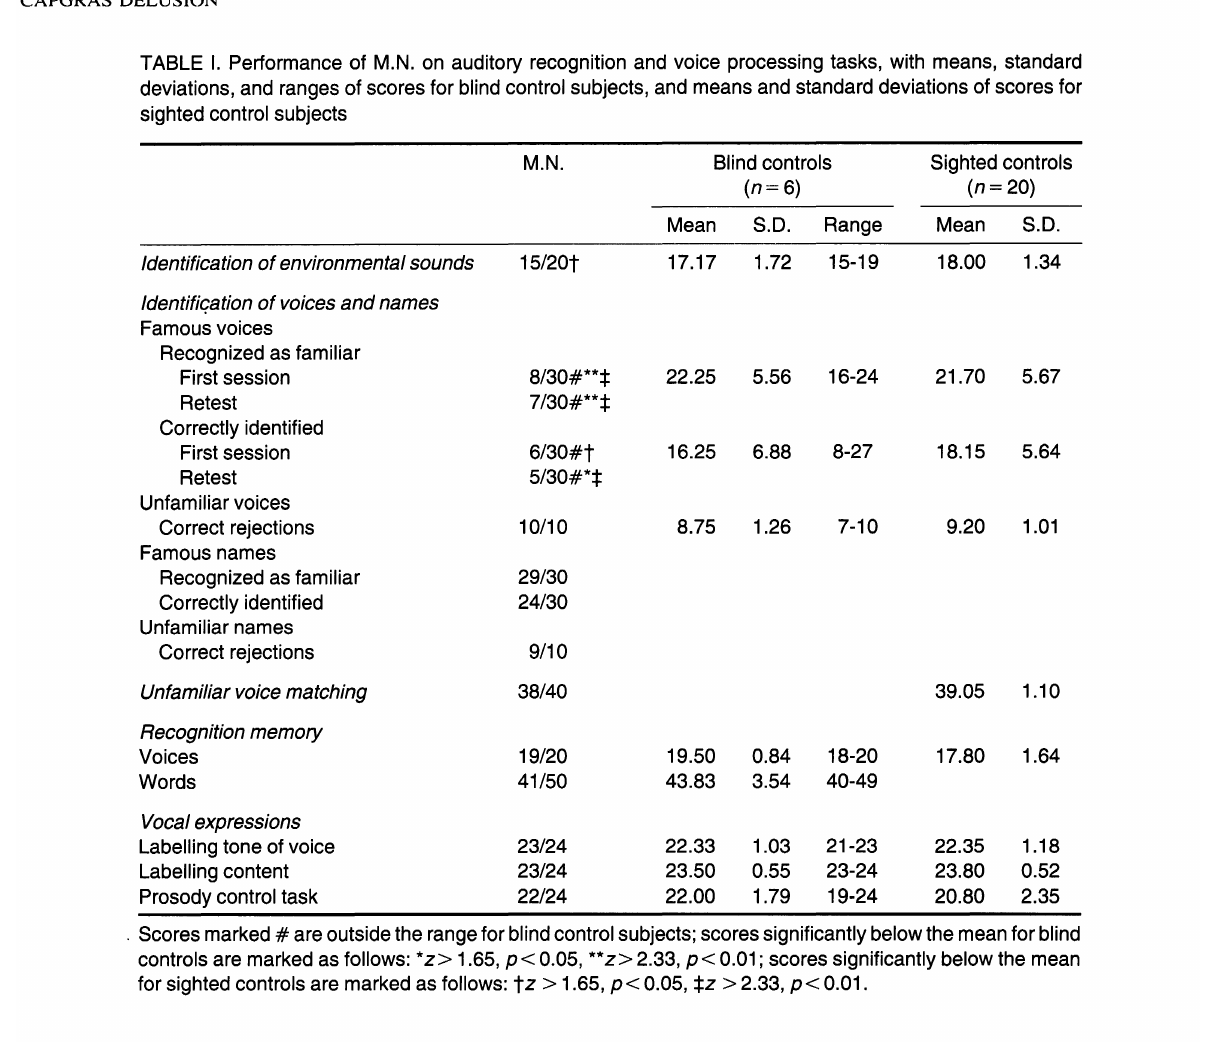
TABLE I. Performance of M.N. on auditory recognition and voice processing tasks, with means, standard deviations, and ranges of scores for blind control subjects, and means and standard deviations of scores for sighted control